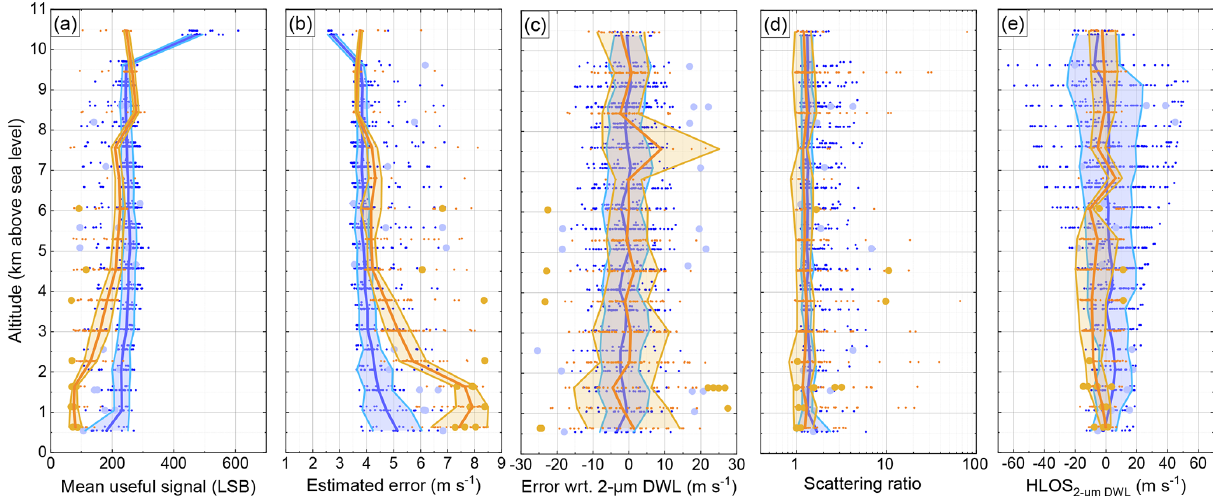
Figure 8. Altitude dependency of the mean useful signal (a) , the estimated error (b) , the Aeolus error with respect to the 2µmDWL ob- servations (c) , the scattering ratio (d) , and the HLOS wind velocity derived from 2µmDWL measurements (e) for Rayleigh-clear wind observations available for the AVATAR-I data set (blue) and the AVATAR-T data set (orange). The actual valid data set is indicated by the small points; the outliers defined by the modified Z -score threshold of 3 are plotted by larger dots. The median value per each range gate is indicated by the solid line, and the shaded area indicates the median plus–minus the scaled MAD for each range